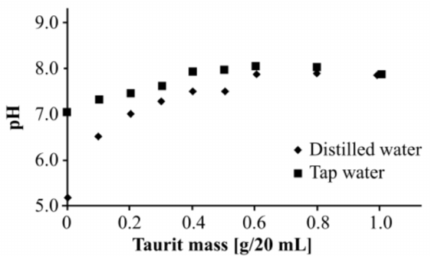
Figure 2. Influence of Taurit mass on